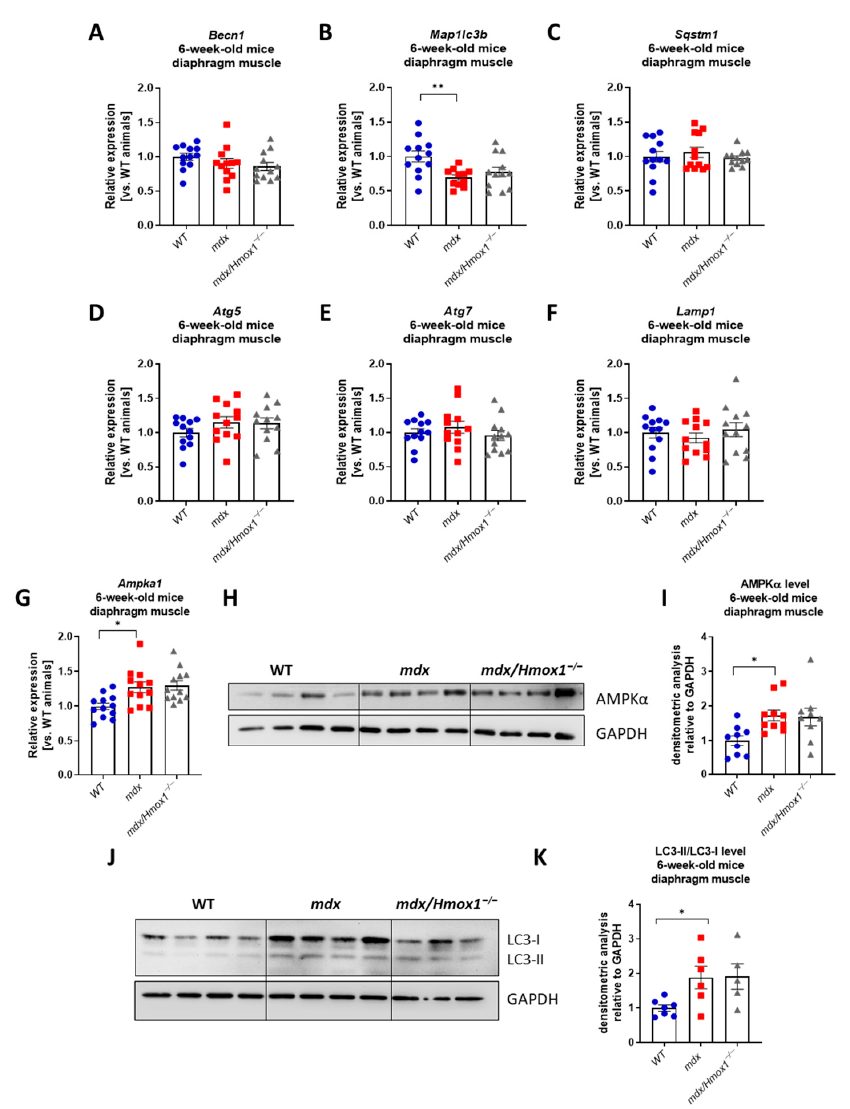
Figure 3. The expression of genes regulating autophagy is not changed by the additional lack of Hmox1 in the diaphragm of 6-week-old dystrophic mice. Analysis of mRNA levels of genes regulating autophagy in diaphragm muscle of WT, mdx , and mdx / Hmox1 − / − animals. The expression of Becn1 ( A ), Map1lc3b ( B ), Sqstm1 ( C ), Atg5 ( D ), Atg7 ( E ), Lamp1 ( F ), and Ampka1 ( G ) was analyzed by qRT-PCR; n = 11–12/group. The protein level of AMPK α presented as a representative Western blot ( H ) and its densitometric analysis ( I ), n = 9–10/group. GAPDH was used as a loading control. Representative Western blot analysis of LC3-I/LC3-II protein ( J ) and densitometric analysis of LC3- II/LC3-I ratio ( K ), n = 5–7/group. GAPDH was used as a loading control. Results presented as mean ± SEM. * p < 0.05, ** p < 0.01 by one-way ANOVA with Tukey’s post hoc test.